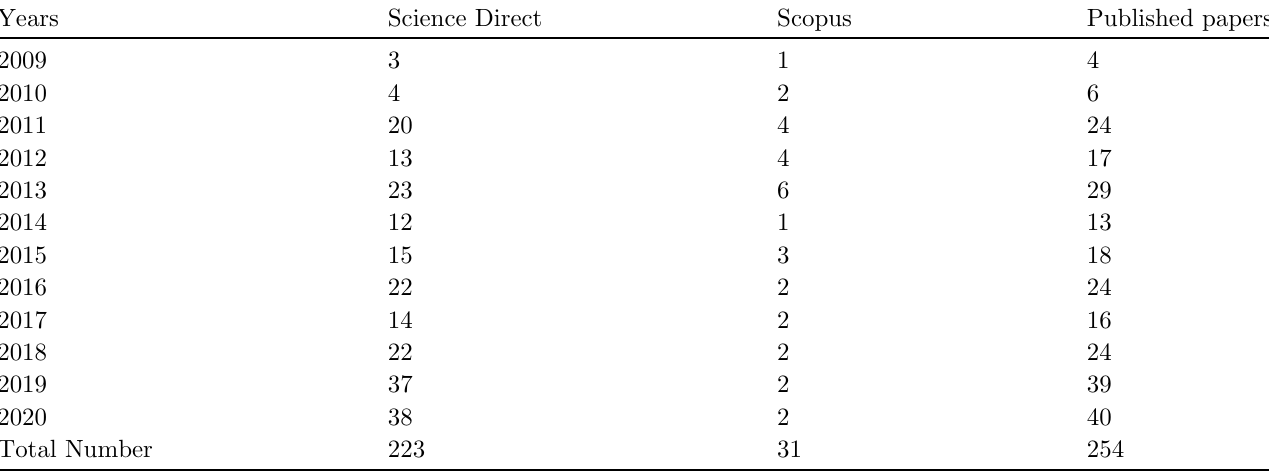
Table 4. Sustainable Biohydrogen production via photo-fermentation and biophotolysis ’ literature search